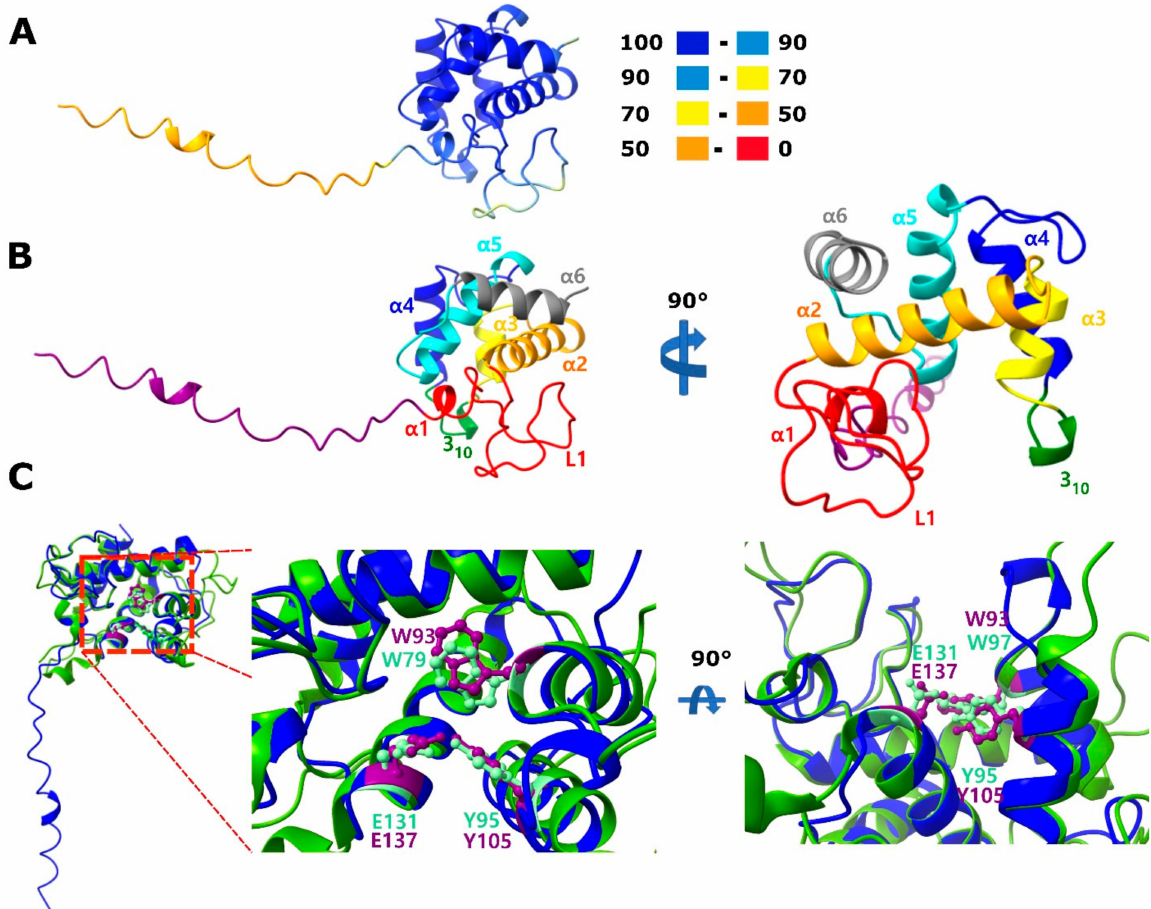
Figure 4. Predicted structure of Pseudoalteromonas phage PM2 protein P5, a putative endolysin. ( A ) AlphaFold2 structure prediction for P5 homologs. Coloring is according to the b-factor as reported by Alphafold2: 100–90: extremely likely, 90–70: well supported, 70–50: low confidence, 50–0: probably disordered. ( B ) Coloring and nomenclature of helices and loops for the portion of P5 predicted with high confidence. Loop 1 (L1), α 2, the single one-turn helix 310 and the N-terminal portion of α 3 form the catalytic groove as suggested for a recently described endolysin [41]. Coloring from N-to C-terminus: purple, red, orange, yellow, green, blue, turquoise and grey. ( C ) Overlay of the predicted P5 structure shown in ( A , B ) (blue) over the experimentally resolved catalytic domain of phage Enc34 endolysin (pdb 7q47, chain A, green, [41]. Conserved amino acid residues hypothesized to be involved in the catalytic activity are highlighted for the reference (light green, W79, Y95 and E131) and P5 (purple, W93, Y105 and E137). Structure figures were prepared with ChimeraX. Amino acid positions are indicated for the catalytic domain as described in 7q47, not for the full